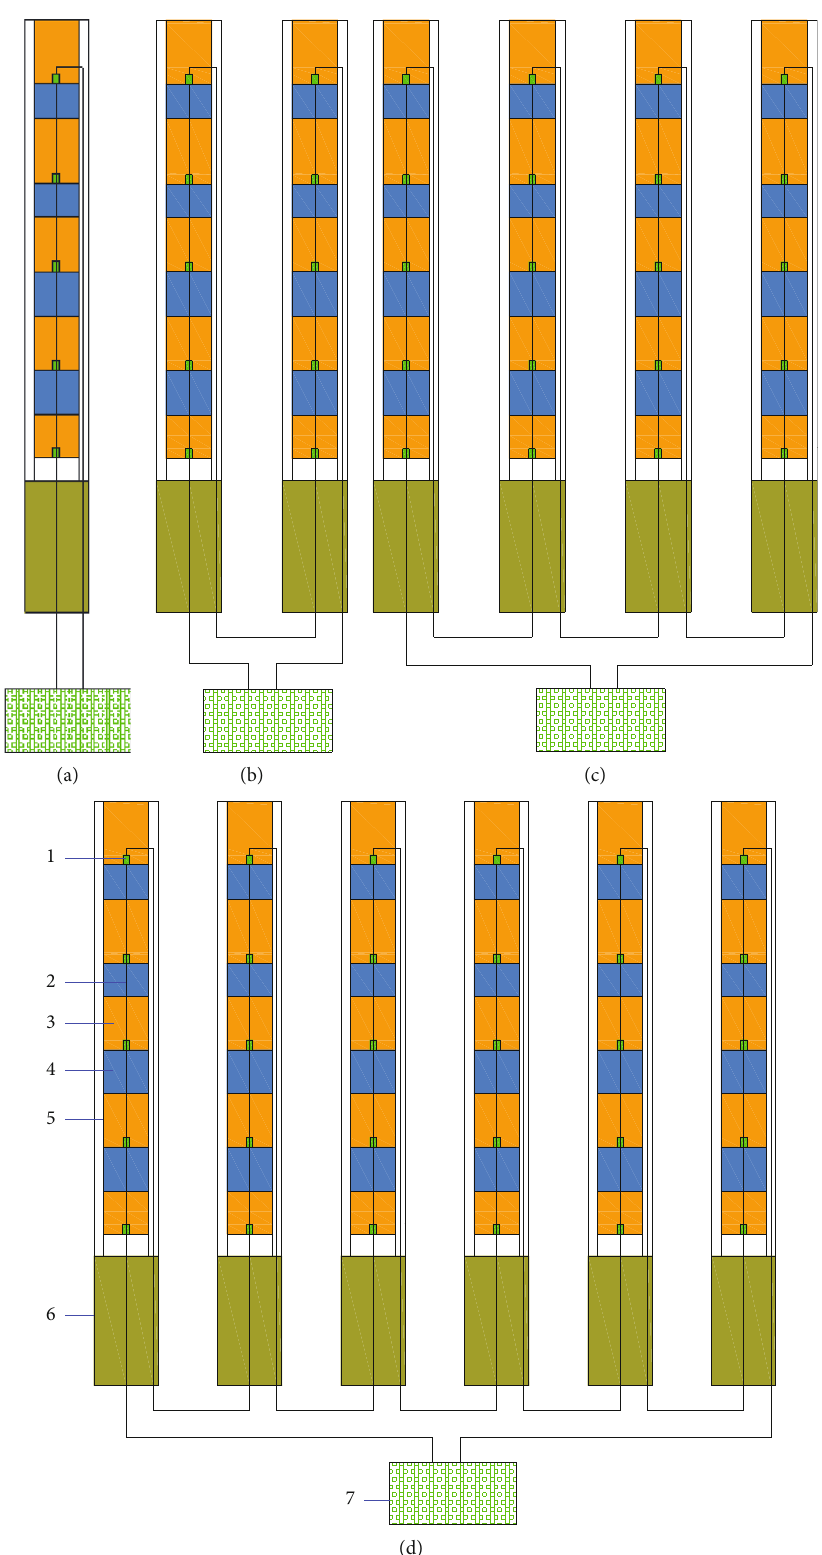
Figure 8: SCHB tests (single-hole charge 4.8kg): (a) single hole, (b) double holes, (c) four holes, and (d) six holes (1: detonator; 2: connecting wire; 3: explosive; 4: water; 5: directional slit tube; 6: sealing mud; 7: detonating